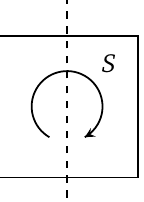
Figure 1: The square torus τ = i , ¯ τ = − 1 is symmetric under 90 degree rotations (modular S ) and reflections. The partition function on the square torus transforms with a phase θ under the former, and must be positive in a reflection-positive theory S due to the